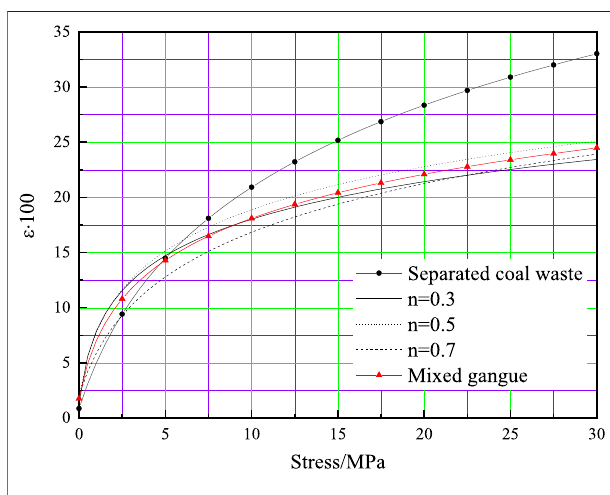
FIGURE 10 | Fitted stress – strain curves.